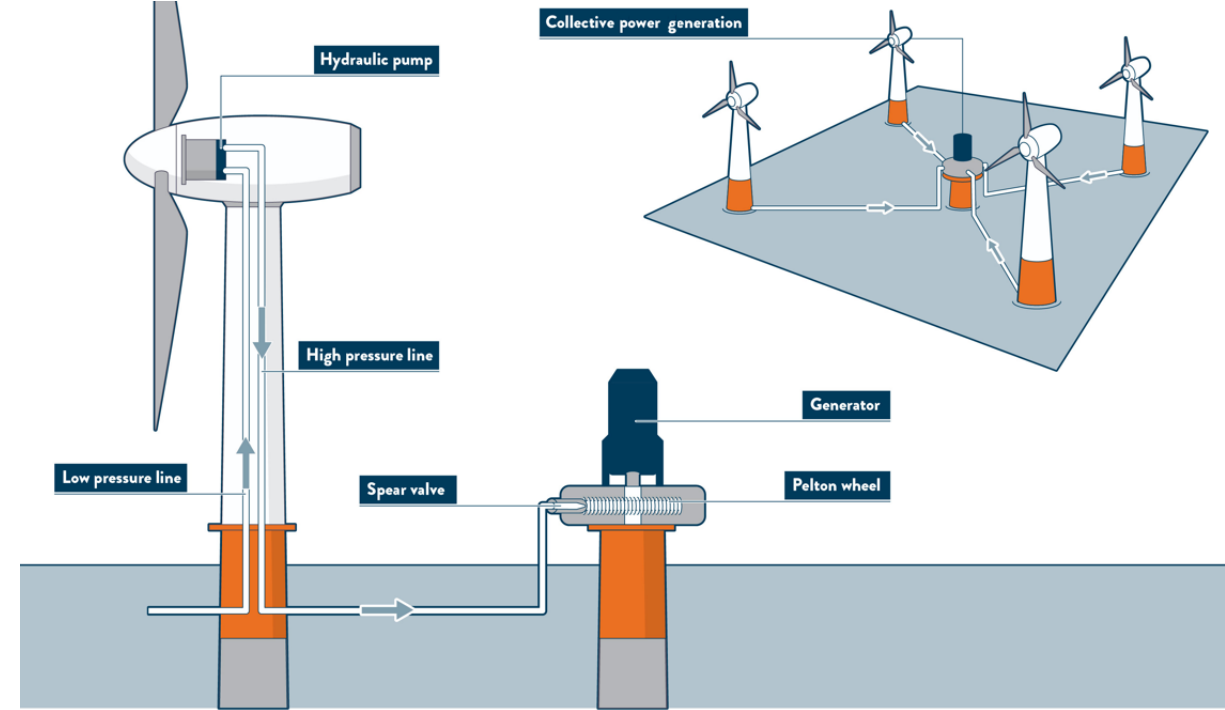
Figure 1. Schematic overview of an ideal DOT hydraulic wind turbine configuration. A radial piston seawater pump is coupled to the rotor in the nacelle. The flow is converted to a high-velocity water jet by a spear valve, and a Pelton turbine–generator configuration harvests the hydraulic into electric energy. Multiple turbines can be connected to the central power generation